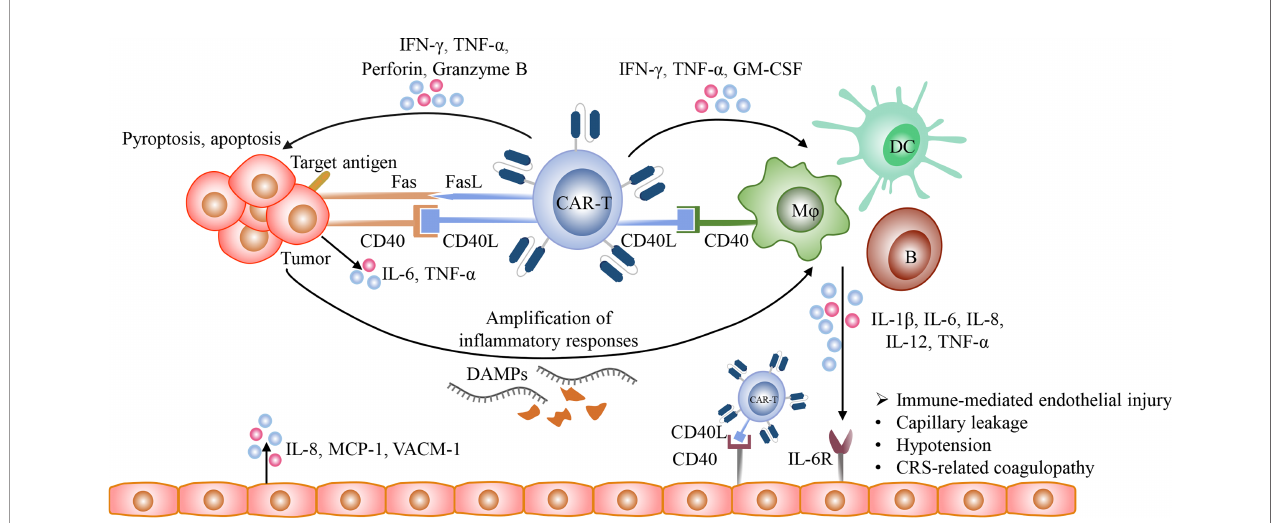
FIGURE 3 | The mechanisms of CRS. After the recognition of target antigens, CAR T-cells rapidly proliferate and release multiple cytotoxic molecules, such as granzyme, perforin, IFN- g , and TNF- a , and upregulate the expression of CD40L and Fas ligand (FasL), and eventually induce pyroptosis and apoptosis of tumor cells. Besides, the CD40/CD40L interactions between tumor cells and CAR T-cells promote Fas-mediated apoptosis. Then the lysed tumor cells release large amounts of DAMPs, such as HMGB1, which could activate innate immune cells, including macrophages and dendritic cells, further amplifying in fl ammatory responses. In addition, the CD40/CD40L interactions participate in the activation of various immune cells, including T cells, B cells, macrophages, dendritic cells, and conditional innate immune cells such as endothelial cells. The activated CAR-T cells with the increased expression of CD40L could activate macrophages and endothelial cells and promote their production of pro-in fl ammatory cytokines in a CD40-dependent manner. The cytokines released from activated immune cells could bind to their receptors on endothelial cells and then mediate endothelial dysfunction, resulting in capillary leakage and the release of procoagulant